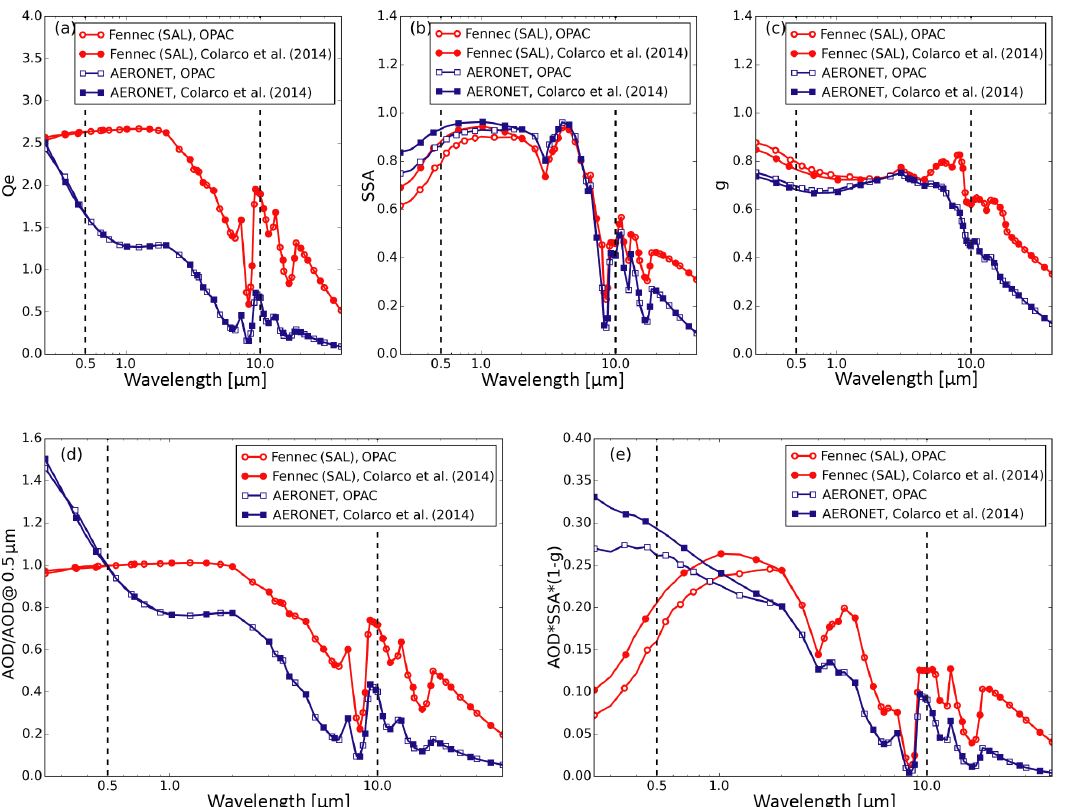
Figure 7. (a) Extinction efficiency ( Q e ), (b) single scattering albedo (SSA), (c) asymmetry factor ( g ), (d) normalized AOD with respect to AOD @ 0.5µm, and (e) AOD × SSA × ( 1 − g ) of dust aerosols based on different combinations of PSD and refractive index. PSD type and refractive index type are indicated in